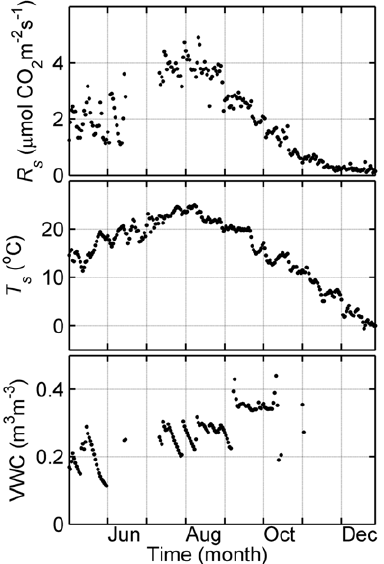
Figure 1. Daily mean of soil respiration ( R s ), soil temperature at 10 cm depth below ground ( T s ), and soil water content at 10 cm depth (VWC) from May to December in 2008.